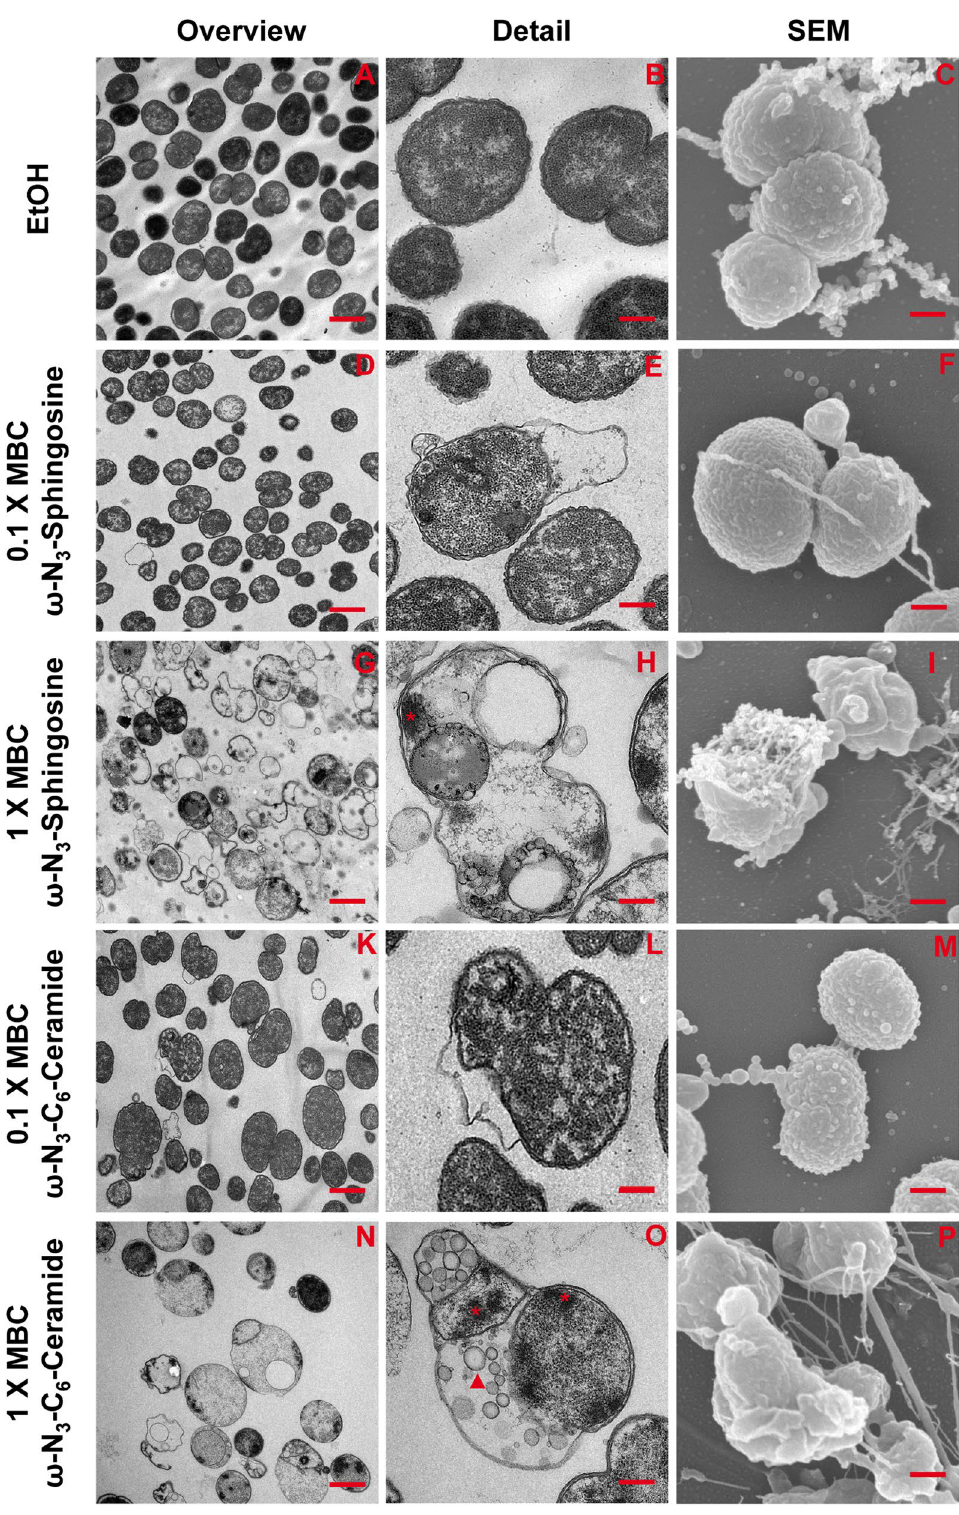
Figure 1. TEM and SEM micrographs show the effect of N. meningitidis treated with azido-modified sphingolipids. Representative TEM or SEM images of N. meningitidis treated with either EtOH ( A – C ), 0.1/1 × MBC of ω-N 3 -sphingosine ( D – F / G – I ) or 0.1/1 × MBC of ω-N 3 - C 6 -ceramide ( K – M / N – P ). N. meningitidis treated with 0.1 × MBC of ω-N 3 -sphingosine or ω-N 3 -C6-ceramide showed a slight alteration of their surfaces and shape ( F , M ) and intact intracellular content. However, some bacteria displayed a strong elongation of the outer membrane ( E , L ). N. meningitidis treated with 1 × MBC of ω-N 3 -sphingosine or ω-N 3 -C 6 -ceramide were distorted to various degrees and their surfaces were wrinkled ( I , P ). Many bacteria appeared in various stages of lysis with compromise of the cell wall and plasma membrane ( G – I , N – P ). Bacteria showed intracellular inclusion bodies appearing in high electron density ( H , O , indicated with asterisks) in electron micrographs and additional vesicles that filled the intracellular content ( O , indicated with arrowheads). First column: TEM overview images, scale bars 1 µm. Second column: TEM detail images, scale bars 0.25 µm. Third column: SEM detail images, scale bars 0.25